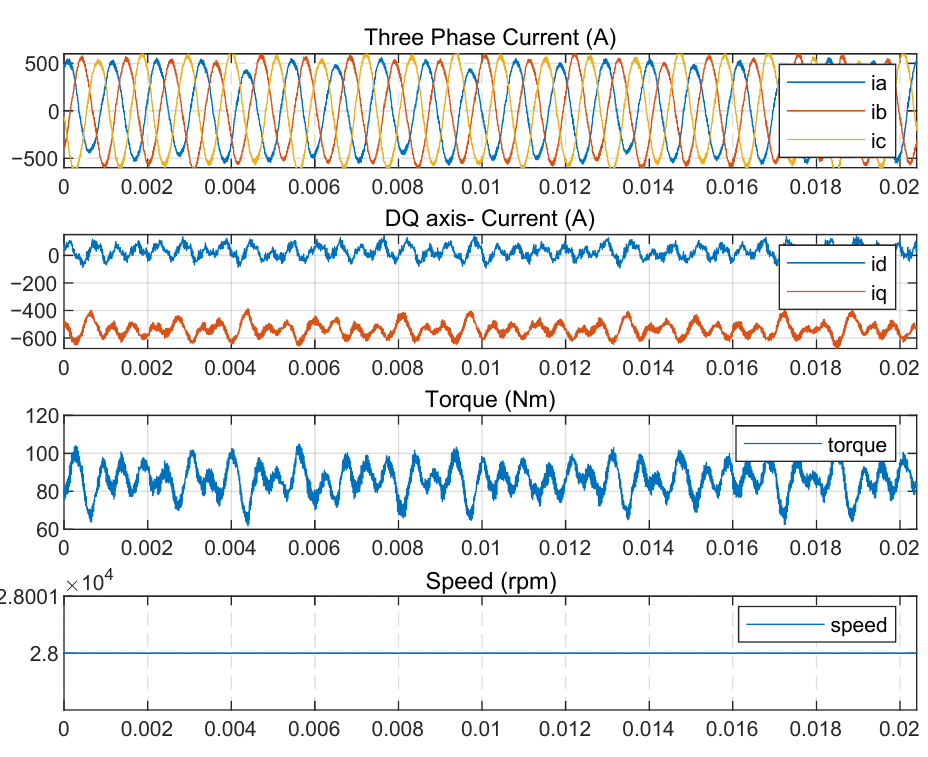
Figure 8. Experimental results of Model